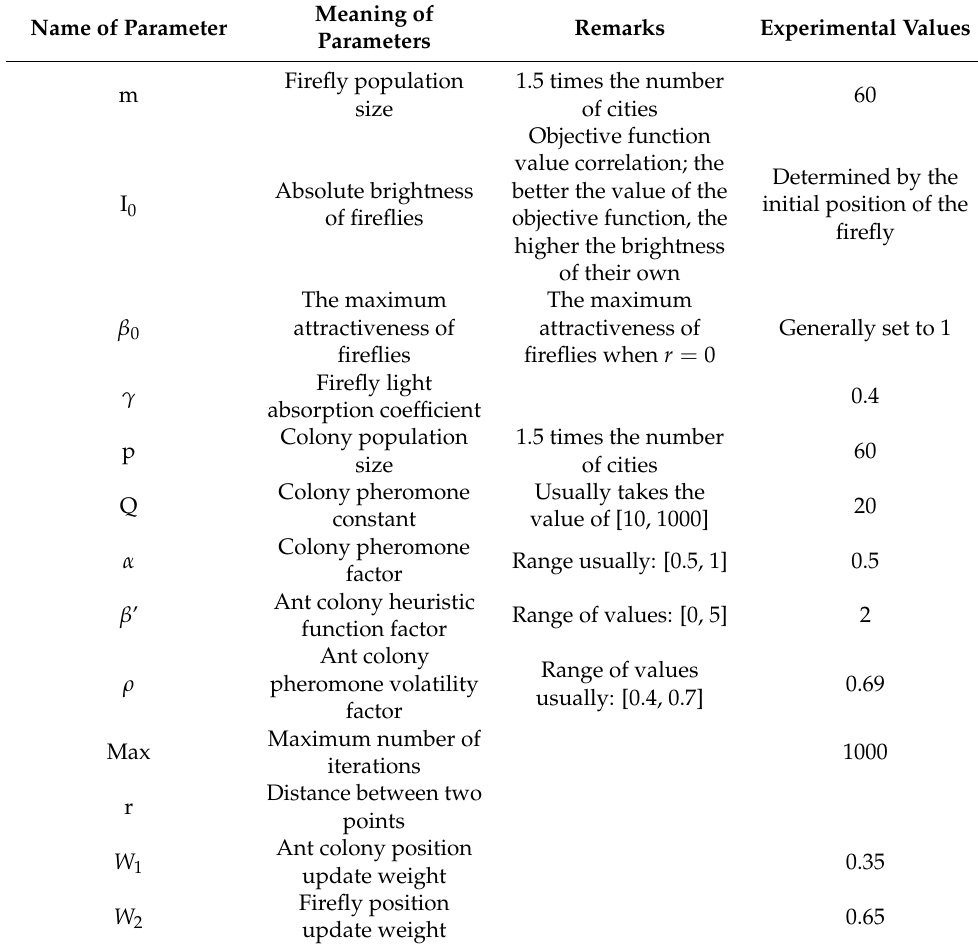
Table 1. The initial parameters of the FaCO